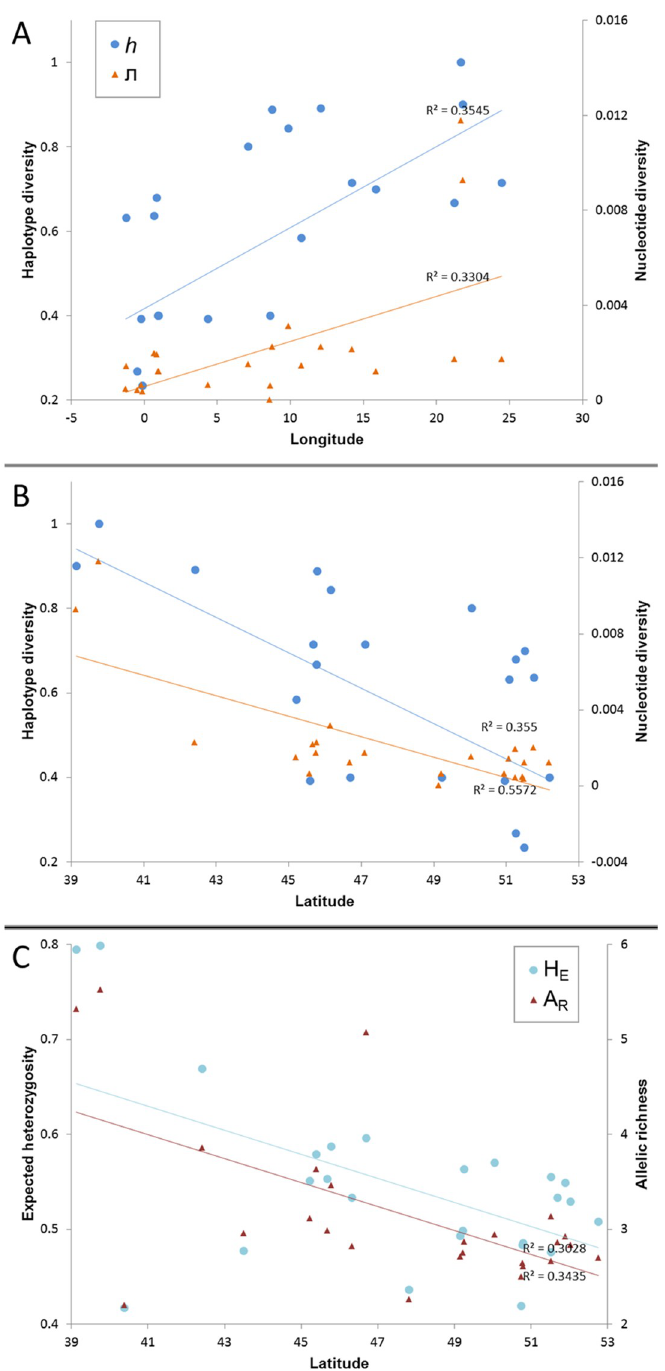
Fig 3. Population-level genetic diversity in relation to latitude and longitude. (A) Haplotype diversity ( h ) and nucleotide diversity ( ᴫ ) based on COI sequences in relation to longitude and (B) in relation to latitude. (C) Expected heterozygosity (H E ) and allelic richness (A R ) based on microsatellite genotypes in relation to latitude.